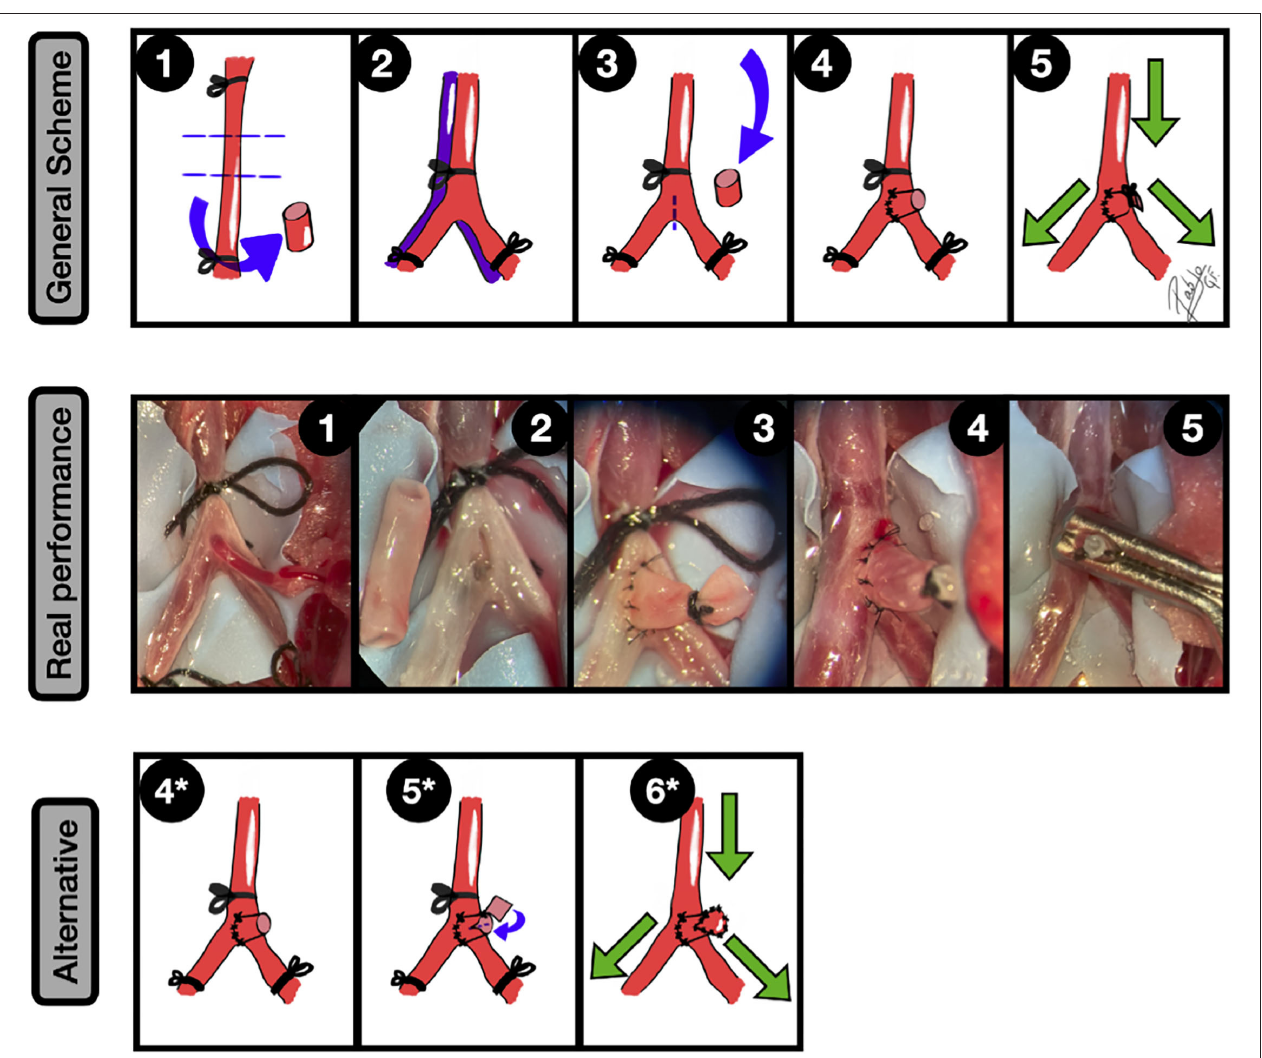
FIGURE 8 | Natural bifurcation aneurysms. General scheme: 1: A free CCA graft is harvested; 2: The AIB is gently dissected from the cava vein and common iliac arteries, paying special attention to the posterior branches and subsequent ligation of the aorta and iliac veins is performed; 3: A longitudinal arteriotomy is made in the anterior arterial wall, near to the bifurcation. After that, the CCA arterial graft is transferred to the abdominal compartment; 4: An end-to-side anastomosis between the graft and the aorta is made; 5: The free lumen of the graft is occluded and the clamps are released, leading to an aneurysm formation in the bifurcation. The green arrows indicate the blood flow direction. Real performance: 1: Exposure of AIB over the blue contrast background. A posterior branch was ligated; The AIB is gently dissected from the cava vein and iliac arteries, paying special attention to the posterior branches, and subsequent ligation of the aorta and common iliac arteries is performed. In the picture, a third aortic caudal branch is observed; 2: A longitudinal arteriotomy is made in the anterior arterial wall, near to the bifurcation, removing the tiny arterial branch. The CCA arterial graft is transferred to the abdominal compartment (left); 3: An end-to-side anastomosis, by interrupted suture, between the graft and the aorta is made. A 6/0 silk ligature is performed to occlude the free lumen of the CCA graft; 4: The clamps are released, leading to an aneurysm formation in the bifurcation; 5: The aneurysm is further clipped. Alternative: 4*: End-to-side anastomosis between the CCA graft and the AIB; 5*: A fish-mouth arteriotomy is performed in the main CCA graft-free lumen, where a second plain arterial graft is fixed by an anchoring knot. 6*: The free lumen is fully covered by this plain graft and the clamps are released, obtaining thus a larger aneurysm. The green arrows indicate the blood flow